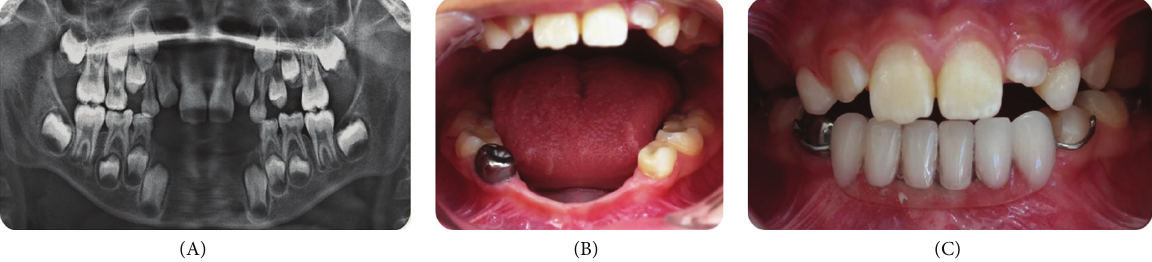
Figure 2: (A) Radiological examination (after 5 months). (B, C) Completed restorations and removable